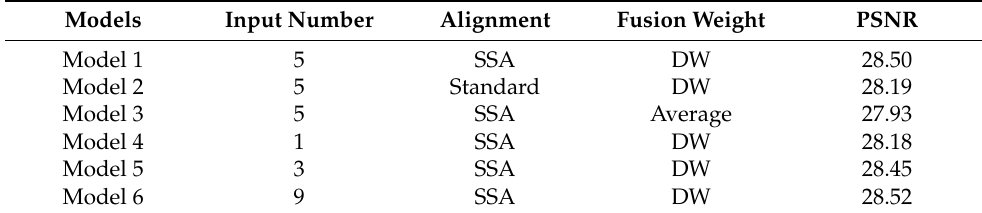
Table 2. Ablation study results on the REDS